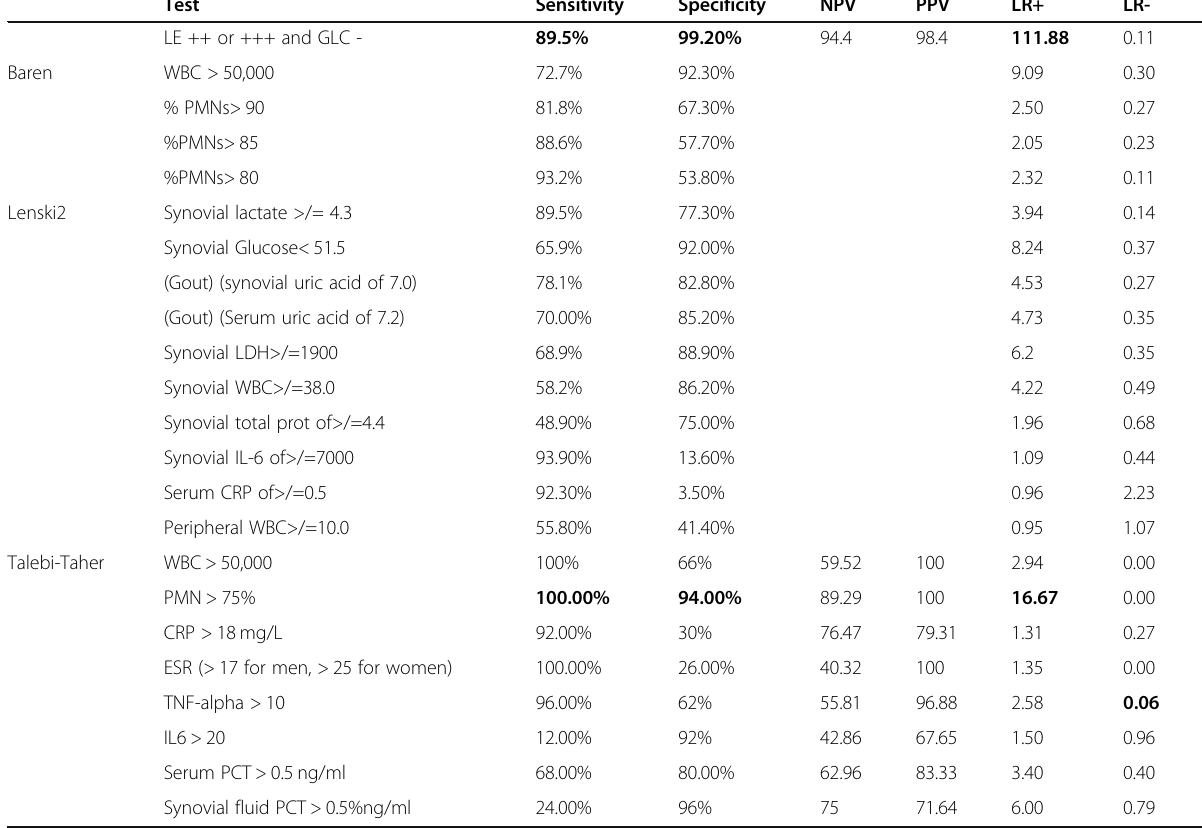
Table 2 Diagnostic Accuracy of Included Tests (Continued)